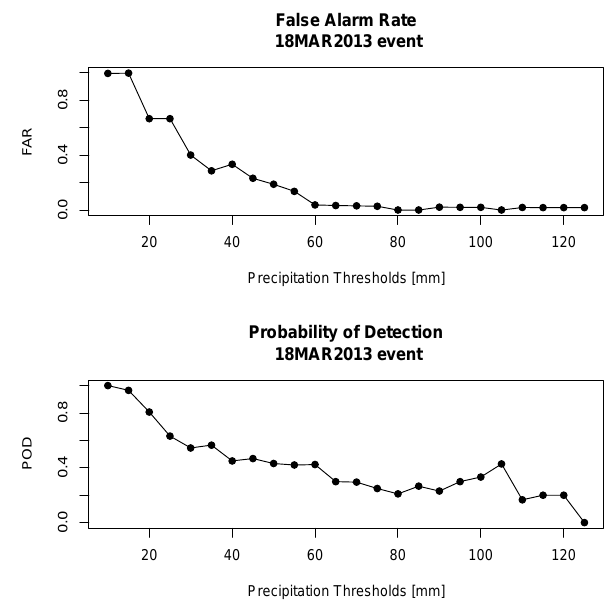
Figure 6. Study case 18MAR2013: false alarm rate (top) and prob- ability of detection (bottom) skills obtained when validating the ac- cumulated 24h rainfall predicted by the WRF model with the rain- fall data observed at rain-gauge locations displayed in Fig.